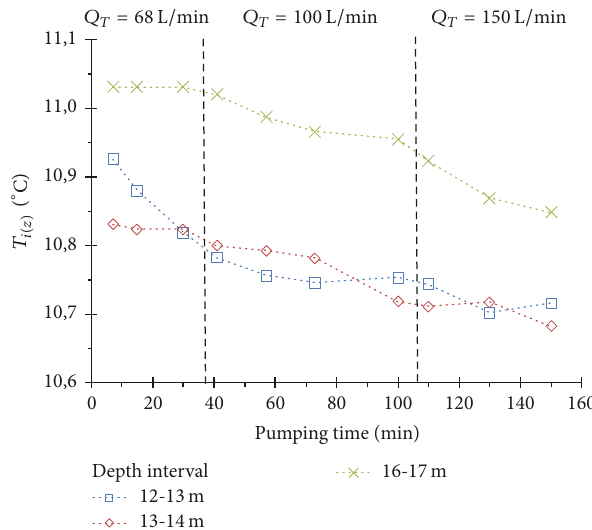
Figure 13: Evolution of main inflow temperatures ( 𝑇 𝑖 (𝑧) ) in well F3 during November 2016